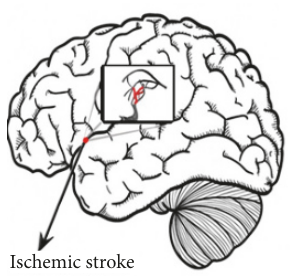
Figure 1: Ischemic stroke